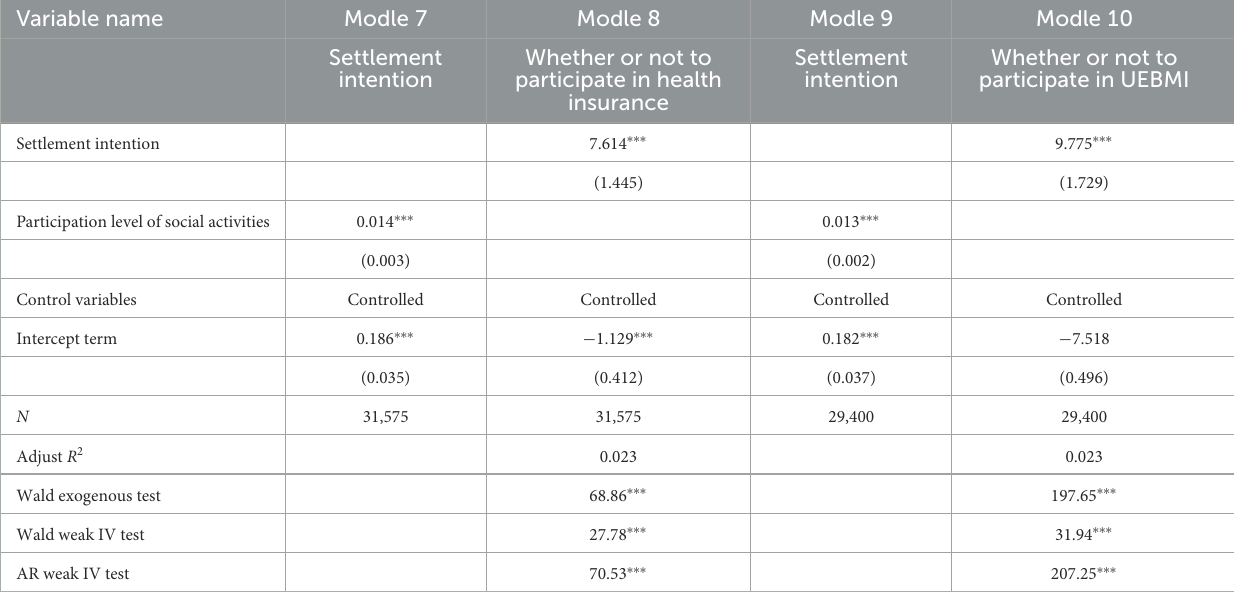
TABLE 5 Estimation results of IV-probit